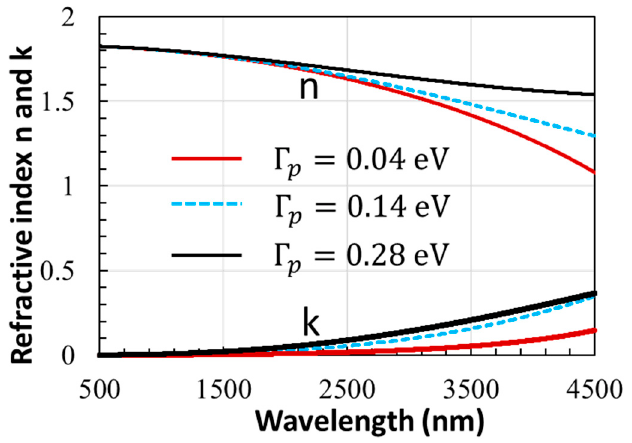
Figure 3. The real (n) and imaginary (k) parts of the refractive index for a wavelength range between 500 and 4500 nm for carrier relaxation rates of 0.04, 0.14 and 0.28 eV in Equation (5).